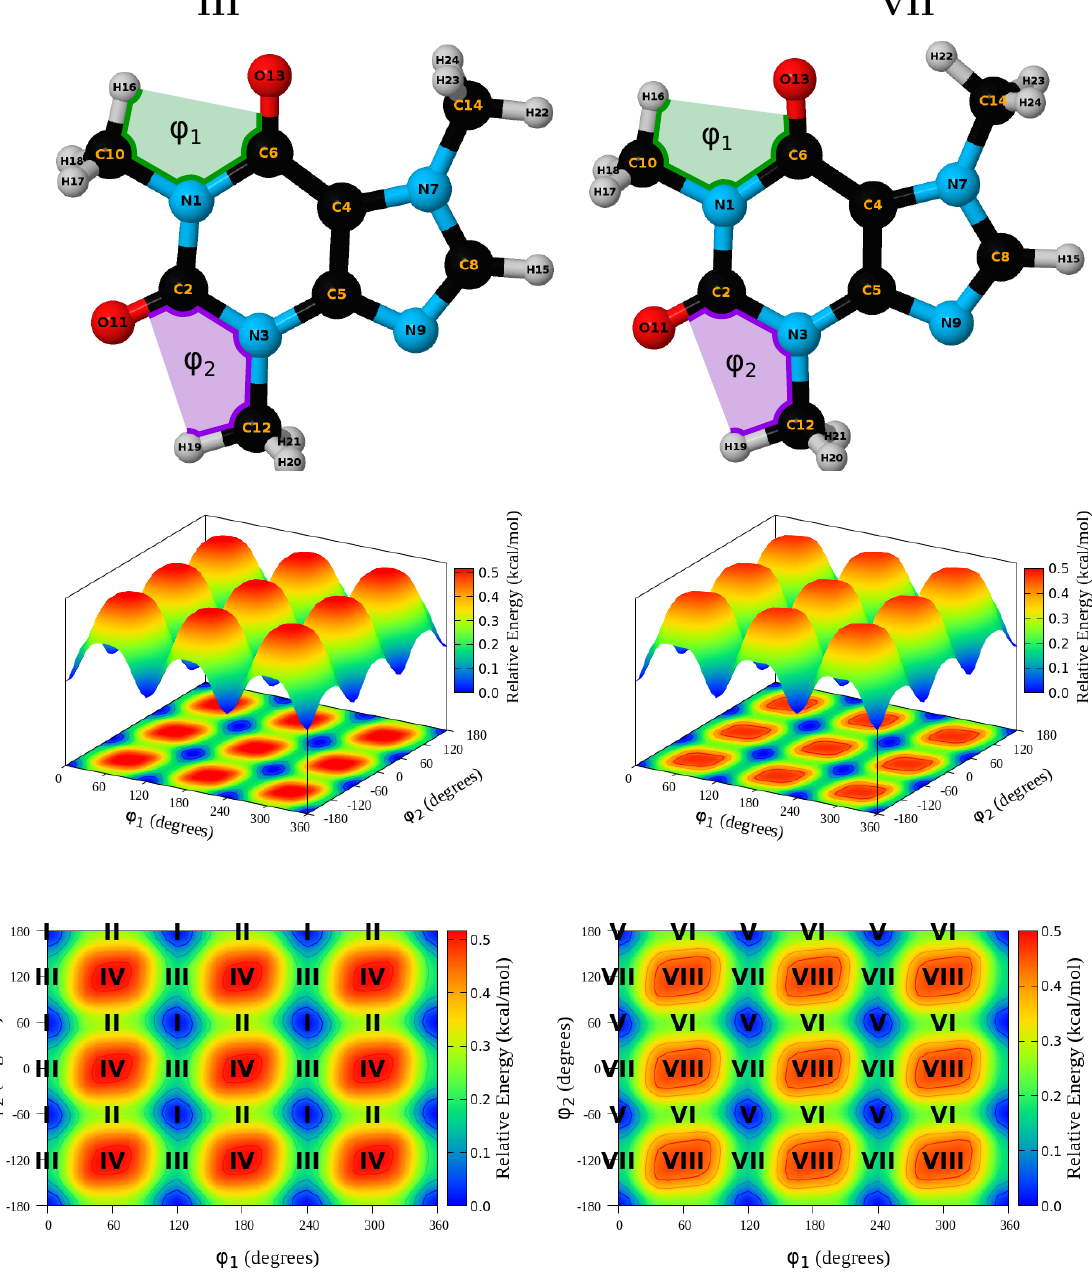
Figure 3. Two dimensional B3LYP–D3/6–311++G( d , p ) relaxed scans to determine the conformations of the two methyl groups (M1, M2) attached to the pyrimidine ring in the two possible conformations of the methyl group attached to the imidazole ring (M3) in